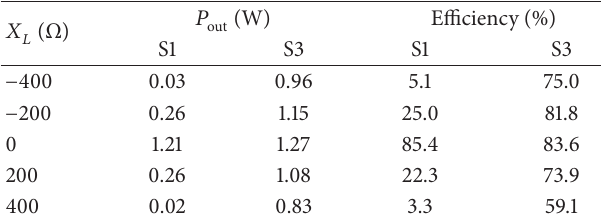
Table 5: Measured power transmission efficiencies and output powers. (The load resistance 𝑅 𝐿 is fixed at 50 Ω .)